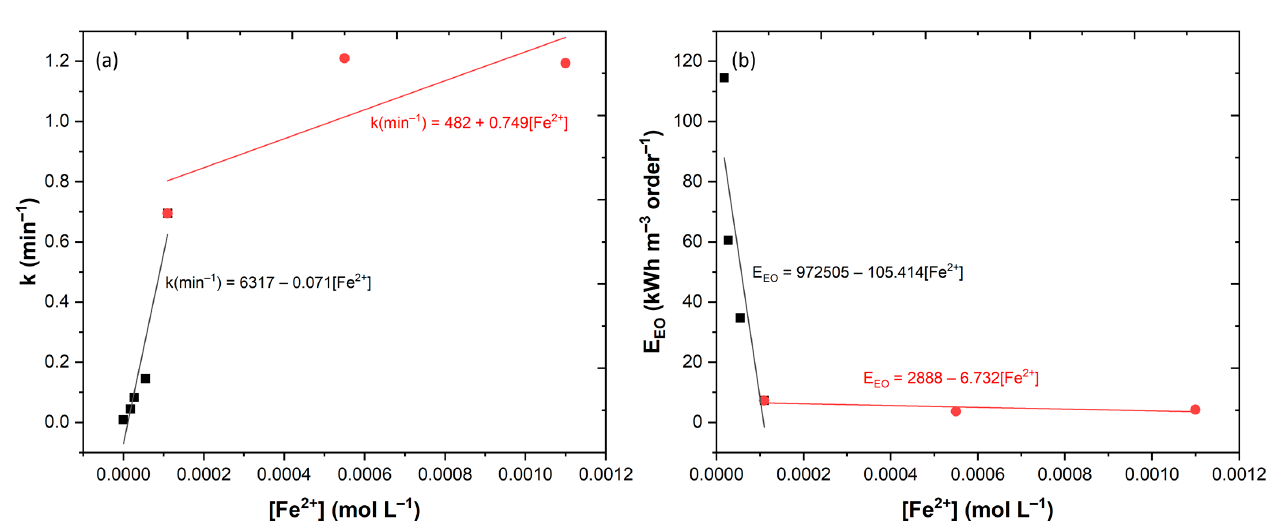
Figure 7. Outcome of several concentrations of Fe 2+ in CA degradation by UV-A-Fenton process; ( a ) dependence on the kinetic constant rates; ( b ) electric energy per order ( E EO ).